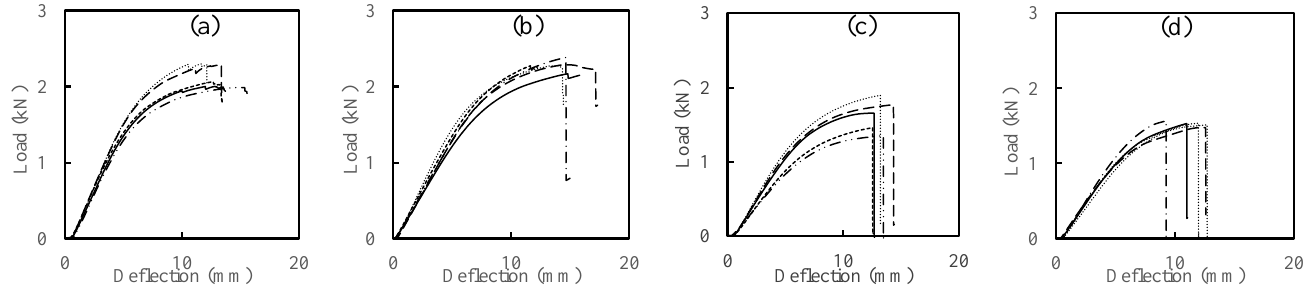
Figure 5. The bending test load–displacement curve: ( a ) red meranti, ( b ) mahogany, ( c ) pine, and ( d ) agathis. (Note: each graph consists of five specimens which were selected randomly from 50 specimens). Table 5. The small timber beams ’ ductility ratio ( μ ).